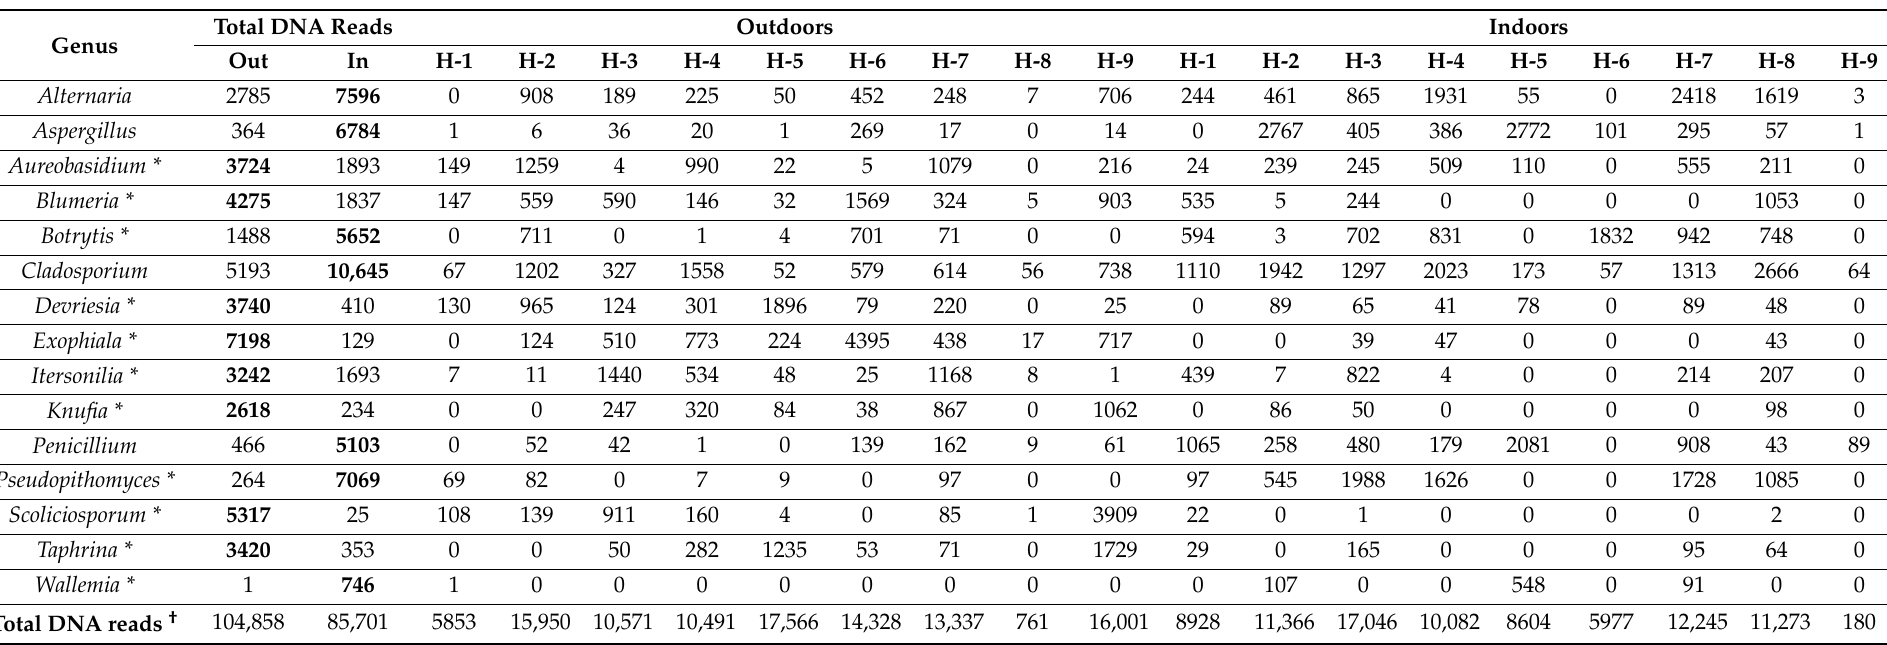
Table 2. Culture-independent identification. The 15 most abundant fungal genera outdoors and indoors at the nine homes (H) and the total reads for the different pooled operational taxonomic units (OTUs). High occurrence indoors compared to outdoors and vice versa are in bold.